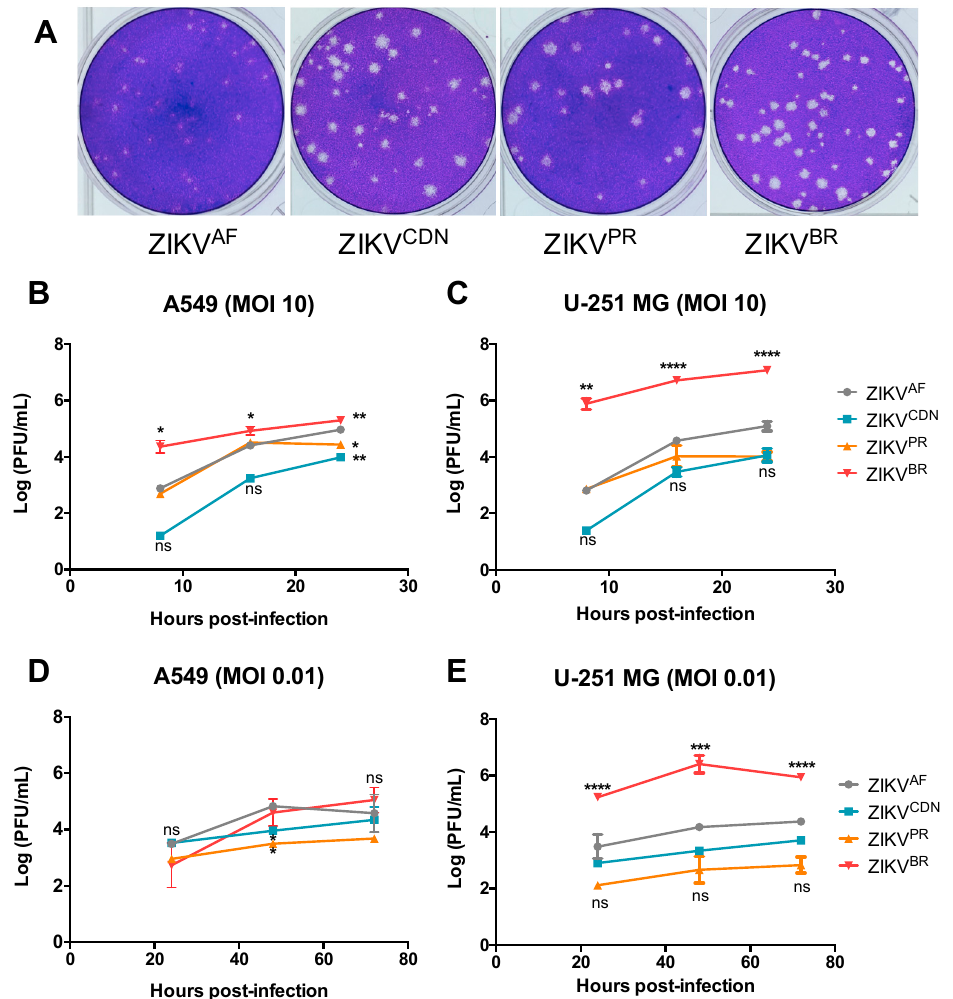
Figure 1. ZIKV isolates demonstrate unique plaque morphology and different growth kinetics in A549 and U-251 MG cell lines. ( A ) Representative images of Vero cell plaque assays of the indicated ZIKV isolates. ( B – E ) Cell culture supernatants were collected at the indicated time points and viral titer was determined by plaque assay. ( B ) A549 and ( C ) U-251 MG cells were infected with ZIKV at MOI = 10. ( D ) A549, and ( E ) U-251 MG cells were infected with ZIKV at MOI = 0.01. Values represent mean ± SD of at least three independent experiments. Asterisks indicate significant differences in viral titer relative to ZIKV AF : * p < 0.05, ** p < 0.01, *** p < 0.001, **** p < 0.0001.